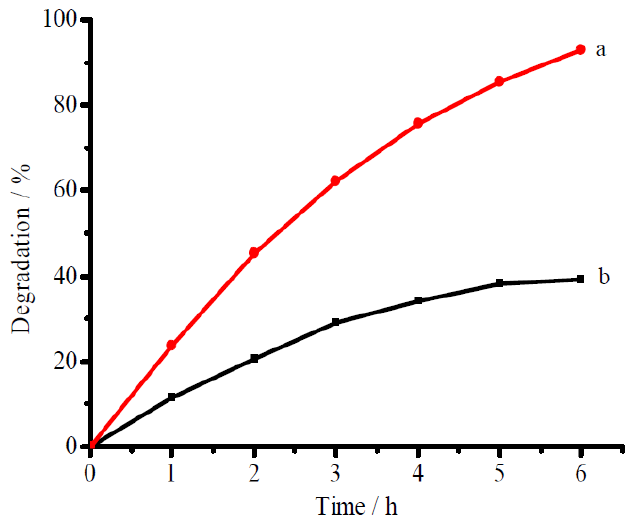
Figure 7. Selective degradation of ammonia ( a ) and RhB ( b ) in a mixed solution containing 100 mg/L ammonia-N plus 50 mg/L RhB. The other conditions are the same as those in Figure 6.